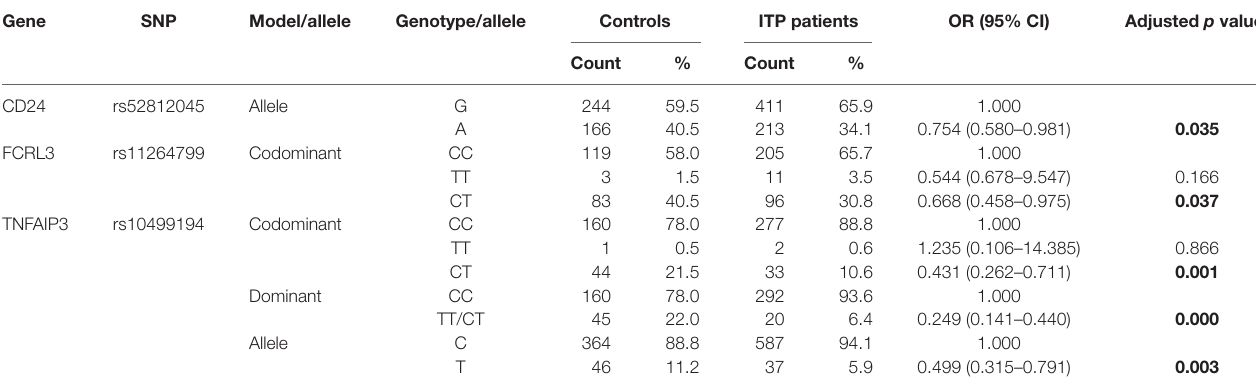
SNP, single-nucleotide polymorphism; CI, confidence interval; OR, odds ratio; ITP, immune thrombocytopenia. Adjusted p value calculated with univariate logistic regression. Bold highlights statistical significance (p <